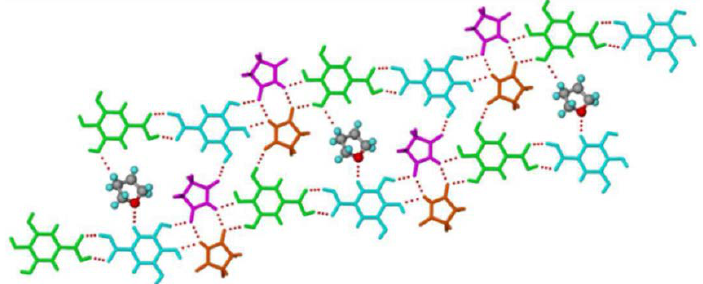
Figure 31. Staircase network in gallic acid-succinimide-tetrahydrofuran (2:2:1) cocrystal [Reprinted from [288] with permission. Copyright 2016 Royal Society of Chemistry].